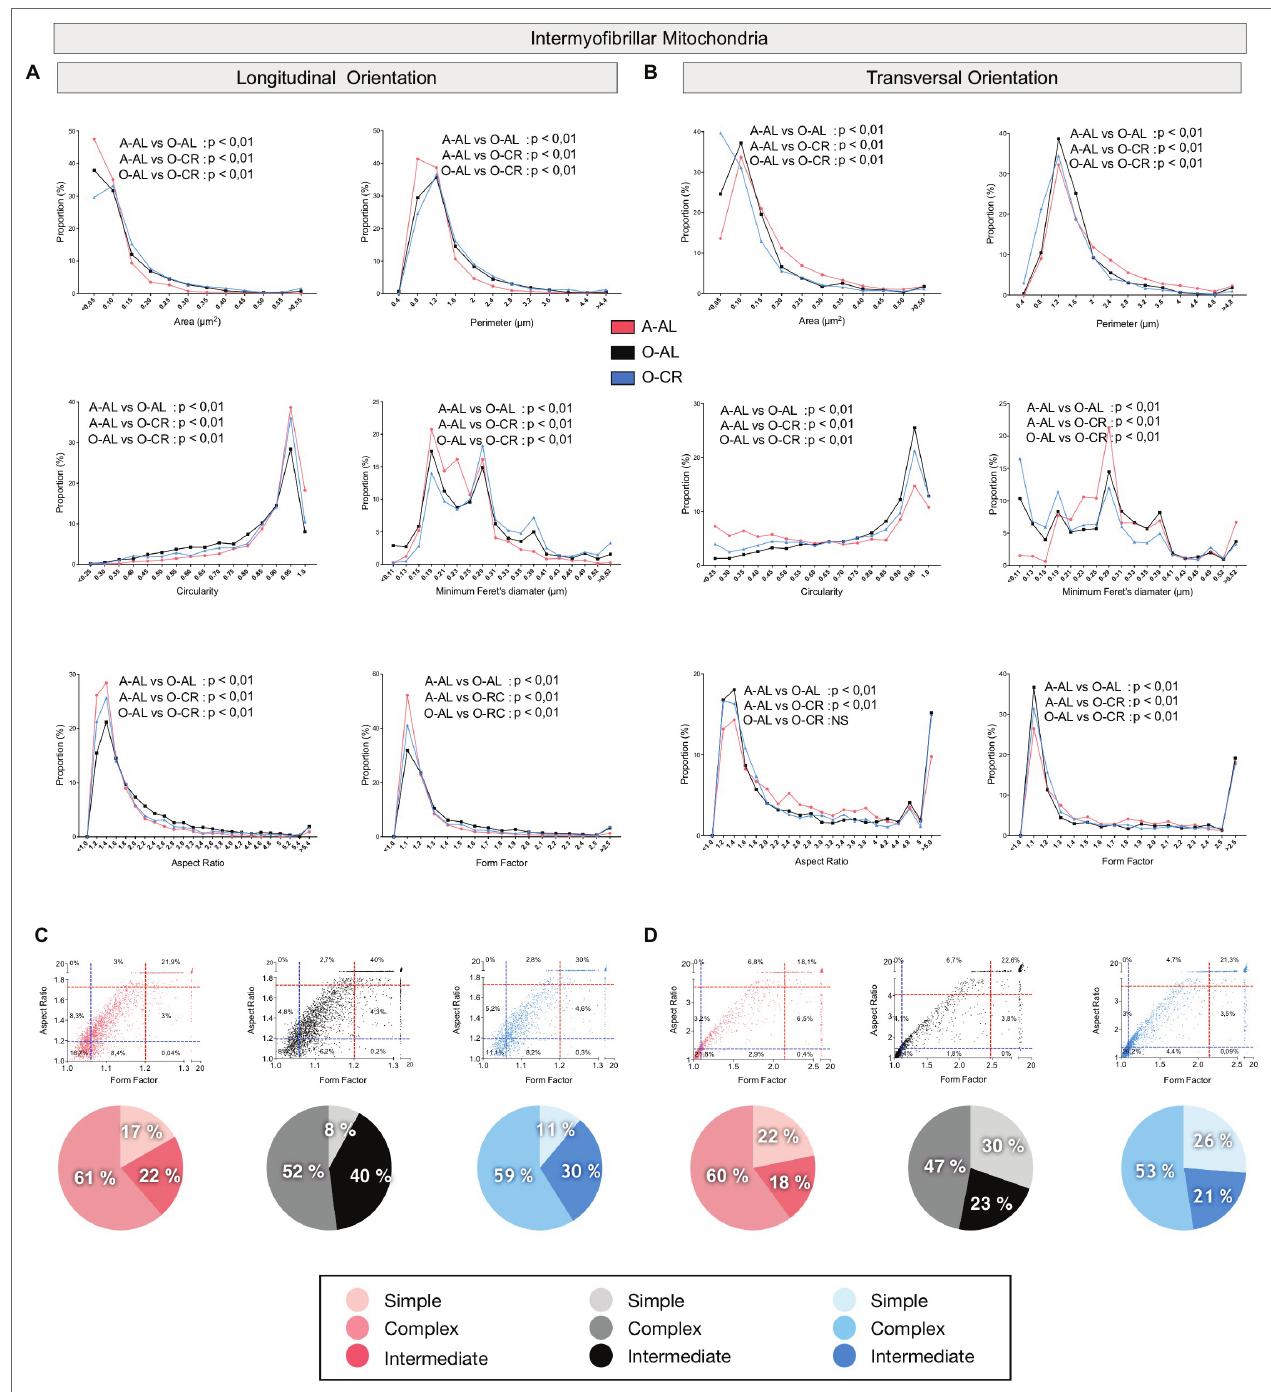
FIGURE 7 | Effect of aging and caloric restriction on the morphology of intermyofibrillar (IMF) mitochondria in the glycolytic white gastrocnemius (WG) muscle. Analyses of morphological parameters of mitochondria IMF in WG muscle (longitudinal and transversal orientations). ( A) and (B) Frequency distribution of shape descriptors and morphological for IMF mitochondria in longitudinal (A) and transversal orientations (B) . (C) and (D) display the form factor and aspect ratio relationship for individual IMF mitochondria for A-AL (left graph), O-AL (middle graph) and O-CR (right graph) rats in longitudinal (C) and transversal orientations (D) . In (C) and (D) , blue and red dashed lines represent the 25th and 75th percentiles for either aspect ratio or form factor values of A-AL, respectively. The pie charts in the second line represent the percentage of mitochondria with simple (i.e. mitochondria with aspect ratio and form factors values inferior to the 25th percentile of A-AL values), complex (i.e. mitochondria with aspect ratio and form factors values above the 75th percentile of A-AL values) and intermediate (i.e. neither simple nor complex). Differences in frequency distributions were tested using a Kolmogorov–Smirnov test comparing cumulative